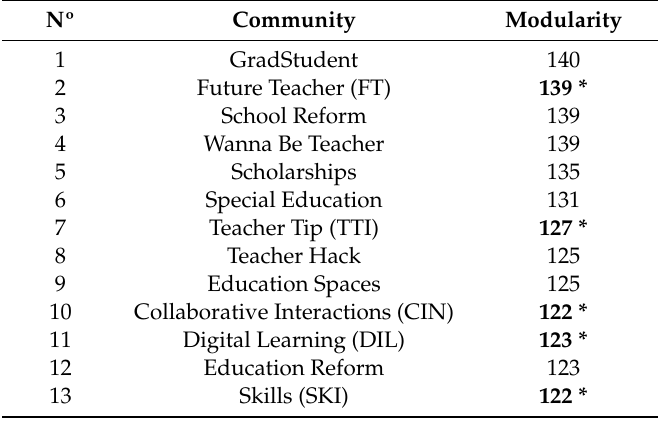
Table 6. Outstanding communities around education and innovation according to MR